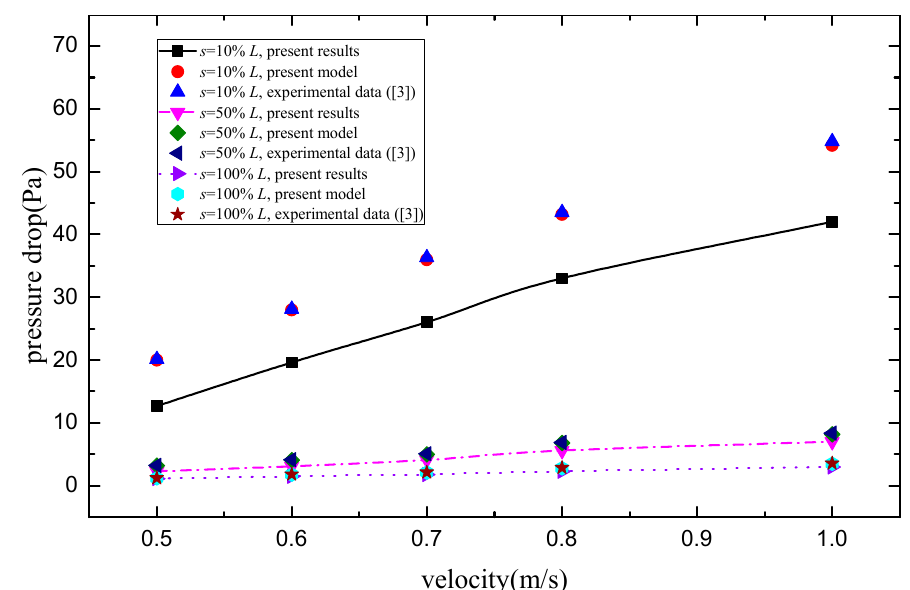
Figure 9. Comparisons of the pressure drop for the #2 plate fin heat sink.